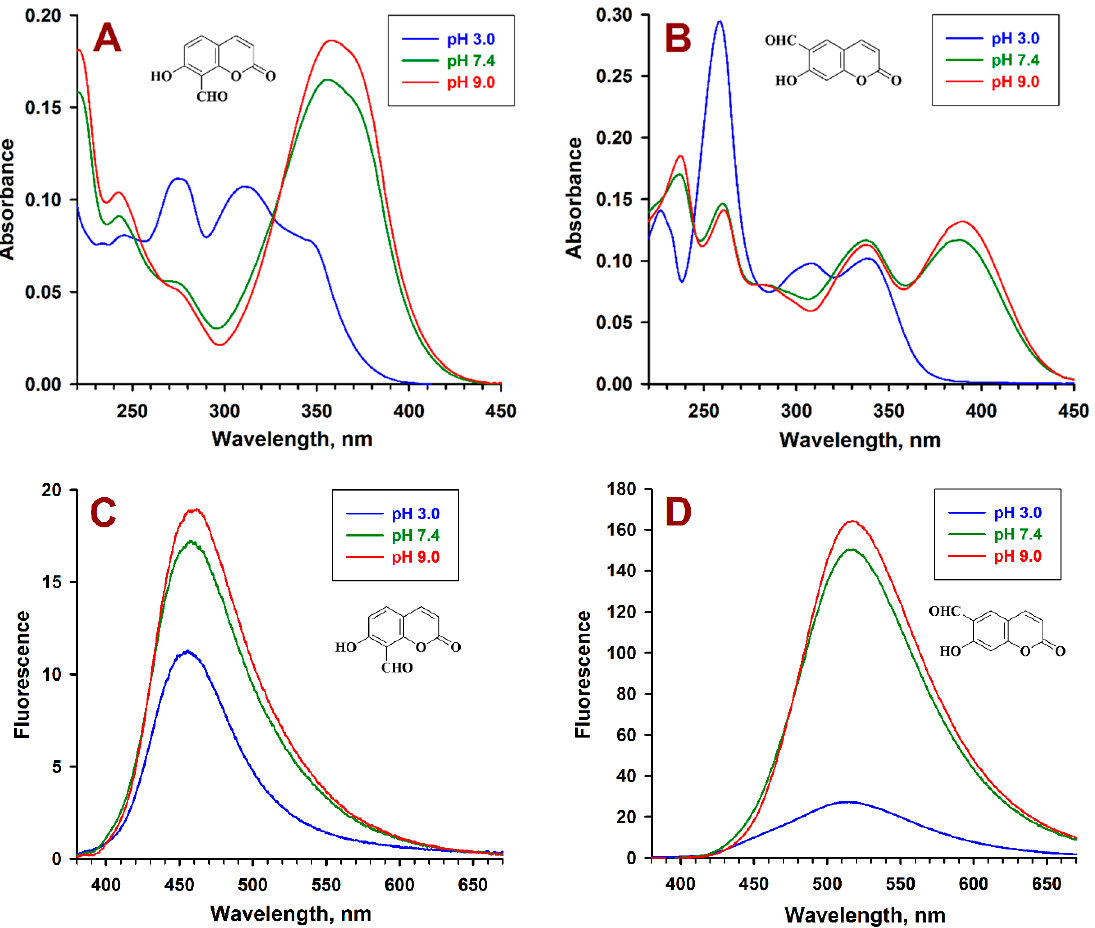
Figure 2. Absorbance spectra of 8-FUmb ( A ) and 6-FUmb ( B ) at various pH, and corresponding fluorescence spectra of 8-FUmb ( C ) and 6-FUmb ( D ) under excitation at 347 nm. Conditions: pH 3.0 = aqueous solutions of 8-FUmb and 6-FUmb were acidified with 1 M aq. HCl to the indicated pH value; pH 7.4 = solutions of 8-FUmb and 6-FUmb in phosphate buffered saline (PBS); pH 9.0 = aqueous solutions of 8-FUmb and 6-FUmb were basified with 1 M aq. NaOH to the indicated pH value. Concentration: 10 μ M, 1% of ethanol.